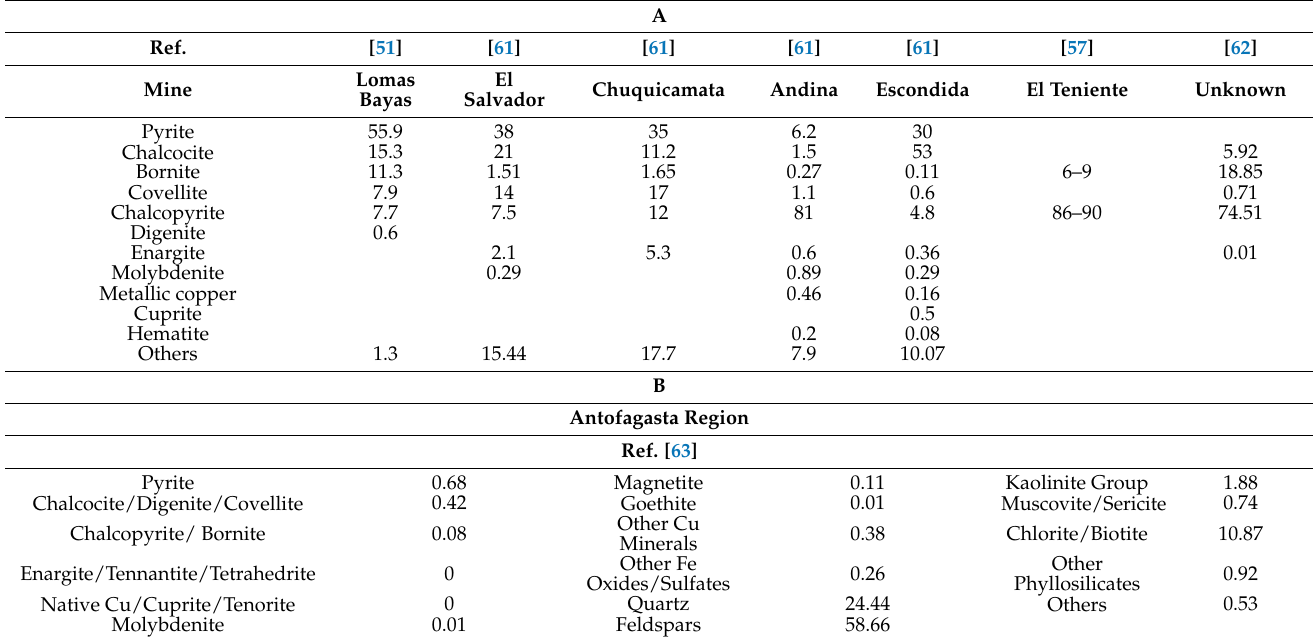
Table 2. Mineralogical composition of copper ore samples from Chile